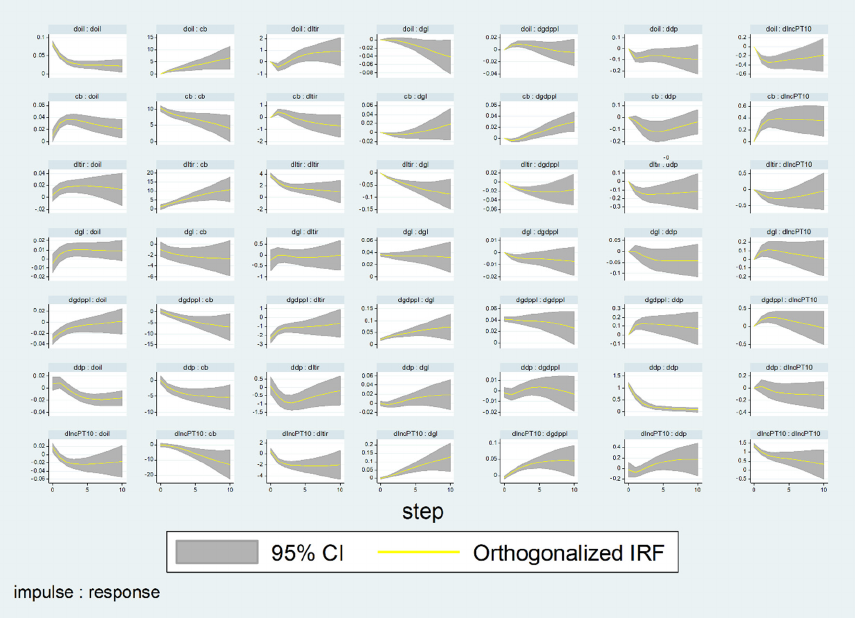
Figure A2. Response of inequality on unconventional monetary policy (heterogeneity channel). Note: The shaded areas refer to the 95% confidence band. Moreover, the IRFs present two periods, which are a short run from zero to four years and a long run from five to 10 years. Therefore, the orthogonalised IRF is interpreted aligned with the short-run and long-run periods as defined. Source: Author’s illustration based on SWIID (Solt 2020; World Development Indicators 2022).